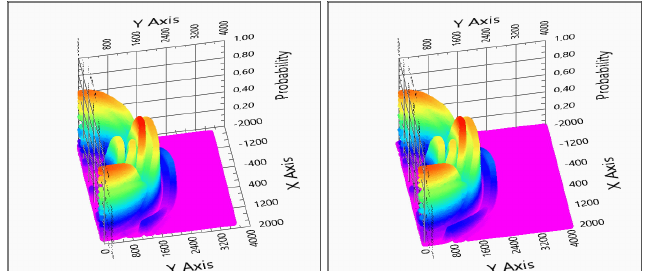
Figure 6. The resulting probability distributions of the occupation of the space with 2 sensors for the reference measurement. The different subplots correspond to the different numbers of evaluated points, i.e., the different size of the evaluated area as listed in the first column of Table A3. The evaluated area varies from 401 by 401 to 4001 by 4001—the grid density did not change.